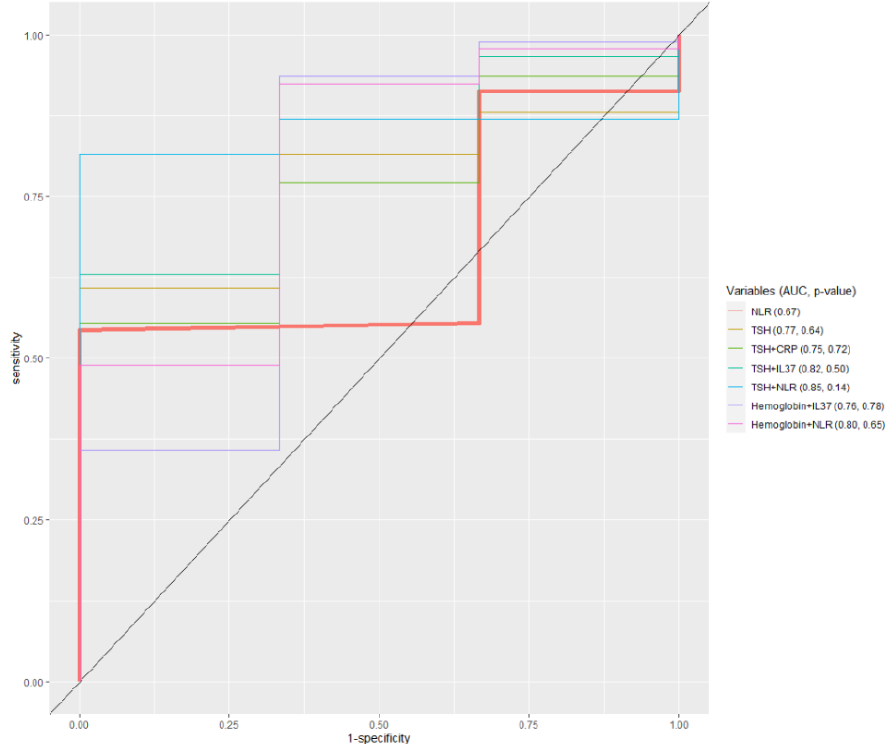
Figure 5. ROC model which discriminates between diabetic women with/without metabolic syndrome.